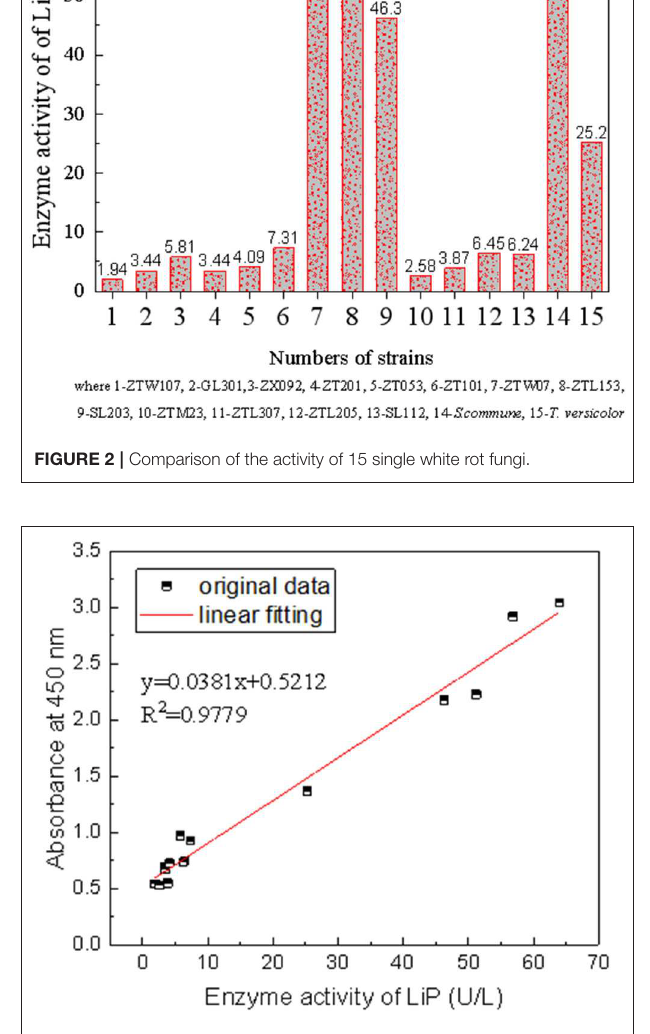
FIGURE 3 | The relationship between the effect of a single strain and the activity of the LiP